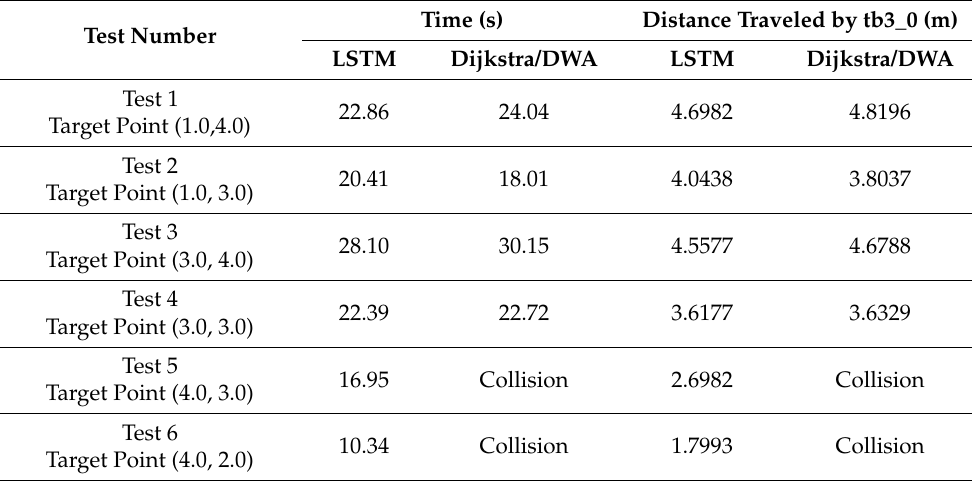
Table 2. Comparison between LSTM and Dijkstra/DWA